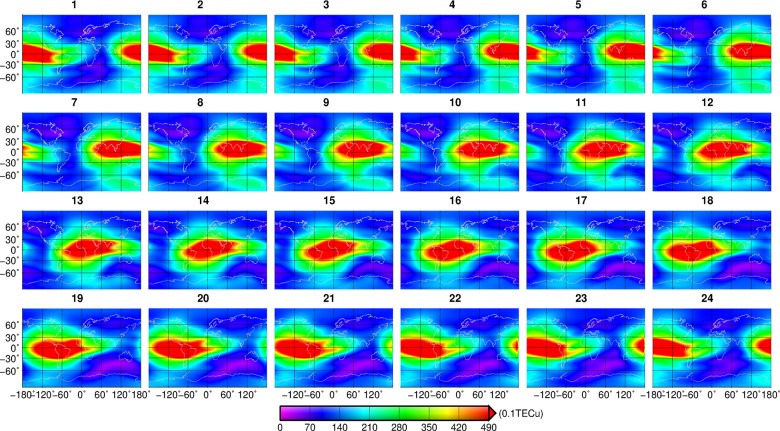
Hourly TECs in UTC.